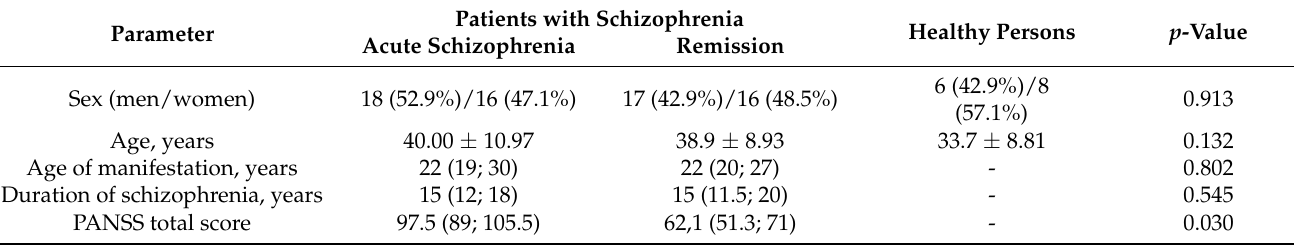
Healthy Persons p -Value